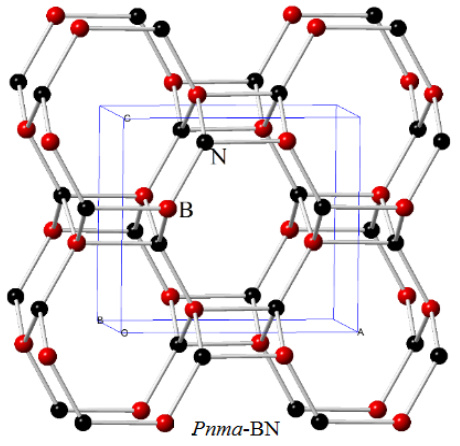
Figure 1. Unit cell crystal structures of BN in Pnma structure. Table 1. The calculated lattice parameters of BN polymorphs.